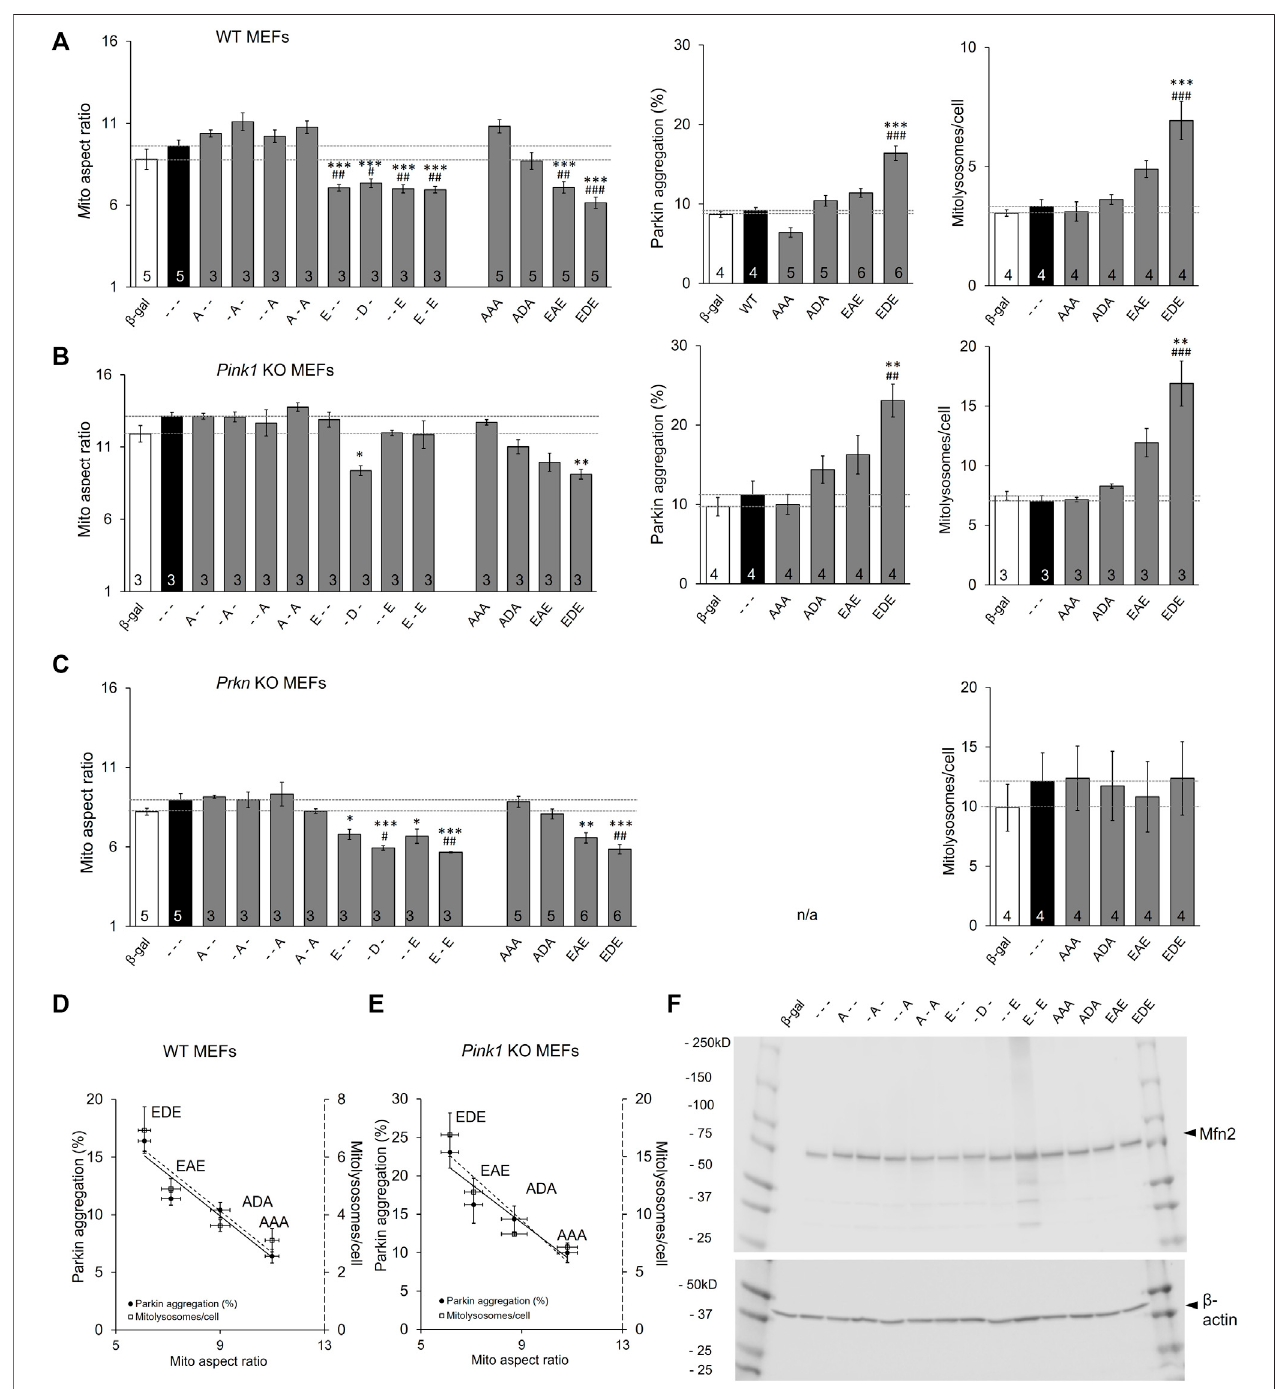
FIGURE 5 | The roles of Pink1 and Parkin in Mfn2-mediated mitochondrial fusion and mitophagy. (A) Results of mitochondrial aspect ratio (left panel), MitoQC studiesmeasuringmitolysosomenumber(middlepanel)andParkinaggregation(rightpanel)inWTMEFs. (B,C) Parallelstudiesin Pink1 KOMEFs (B) and Prkn KOMEFs (C,D,E) AR vs. Mitophagy graph as a function of phosphorylation in WT MEFs (D) and Pink1 KO MEFs (E) . (F) . Immunoblot analysis ofadeno-MFN2 mutant expression inMfn1/Mfn2DKOMEFs.Nshownisnumberofindependentexperiments.Mutantvs.adenoWTMfn2: p < 0.05*; p < 0.01**; p < 0.001***;MFN2vs.adeno β -gal: p < 0.05 #; p < 0.01 ##; p < 0.001 ###, all by ANOVA. Error bars are SEM.